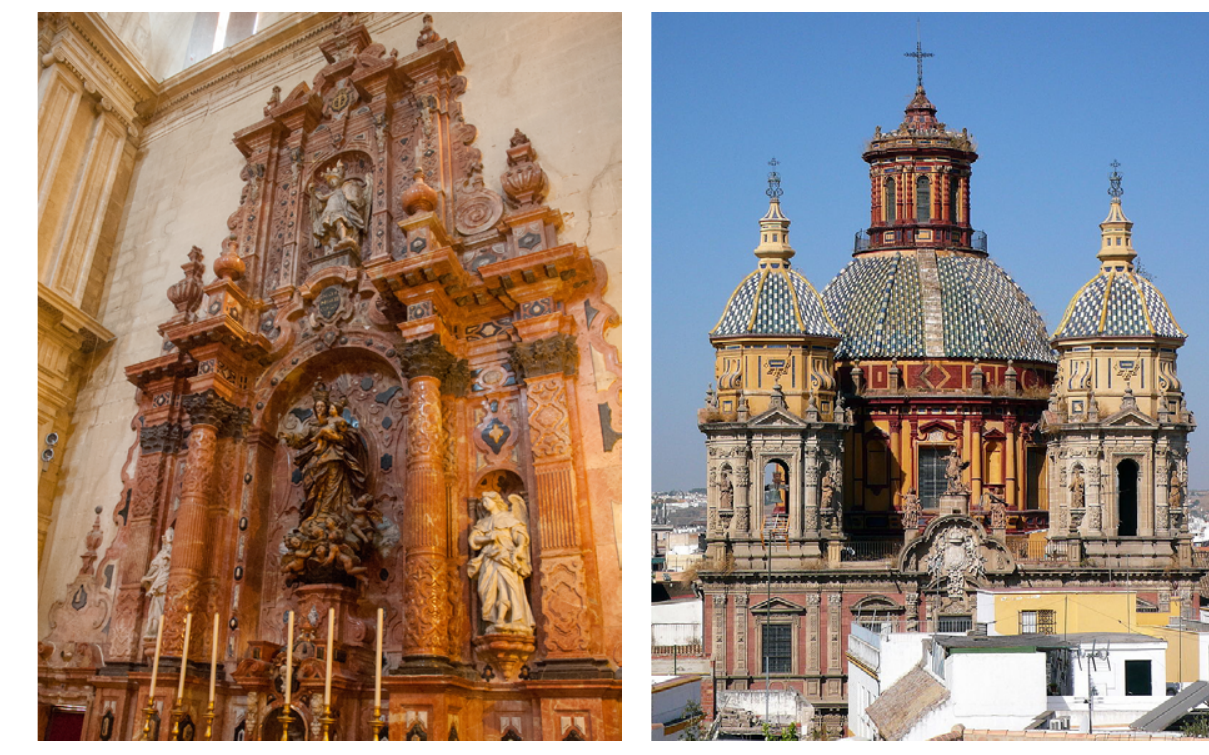
Figure 17: The red marble retablo of the Magdalene located in the Epistle transept. Image from http://www.